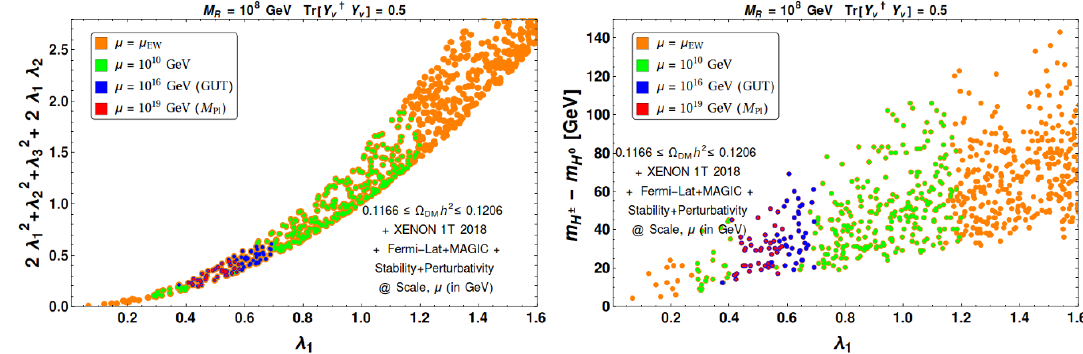
+ (cid:21) 2 + (cid:21) 2 + 2 (cid:21) 1 (cid:21) 2 1 2 3 Y (cid:23) ] = 0 : 5 with (cid:23)